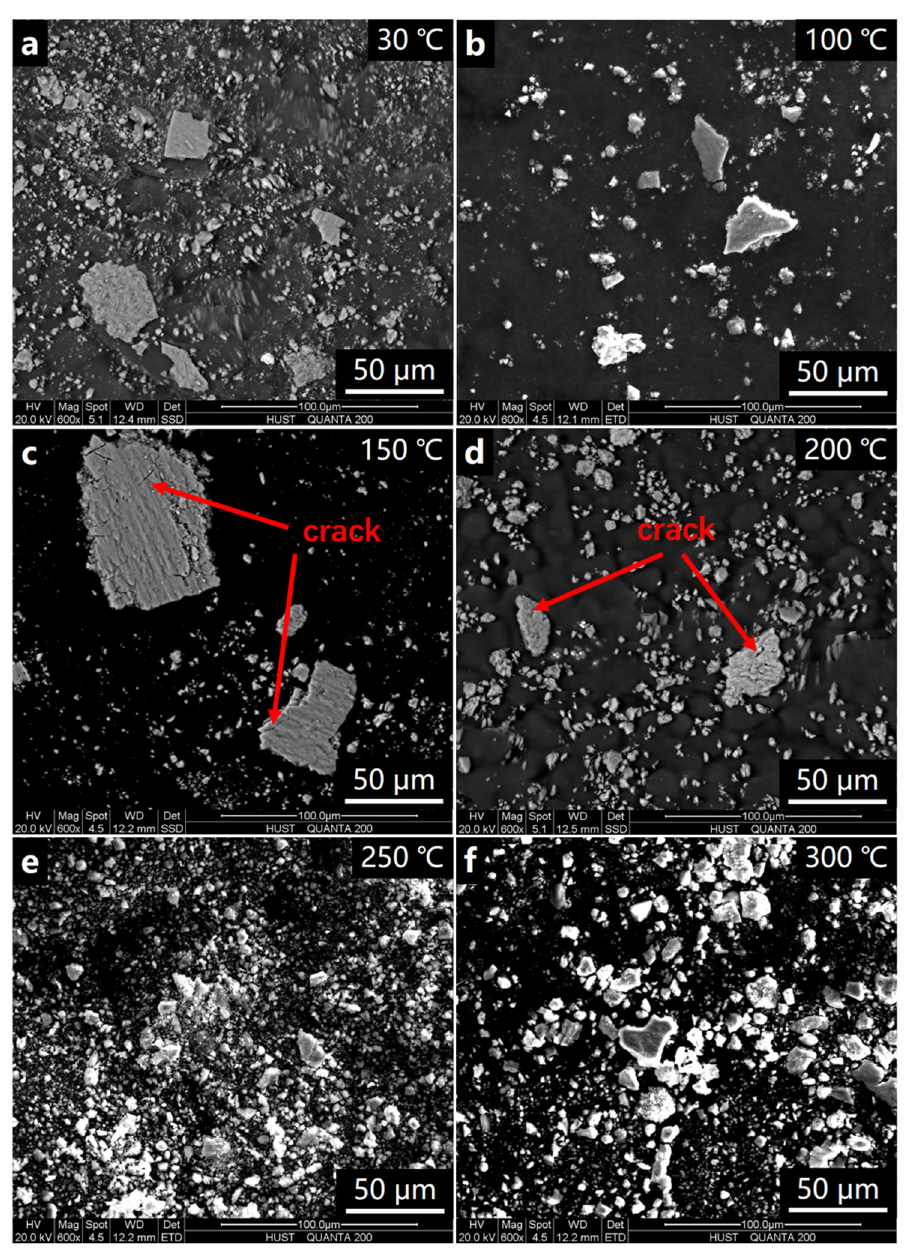
Figure 7. ( a – f ) SEM micrographs of wear debris of 30 °C, 100 °C, 150 °C, 200 °C, 250 °C and 300 °C.